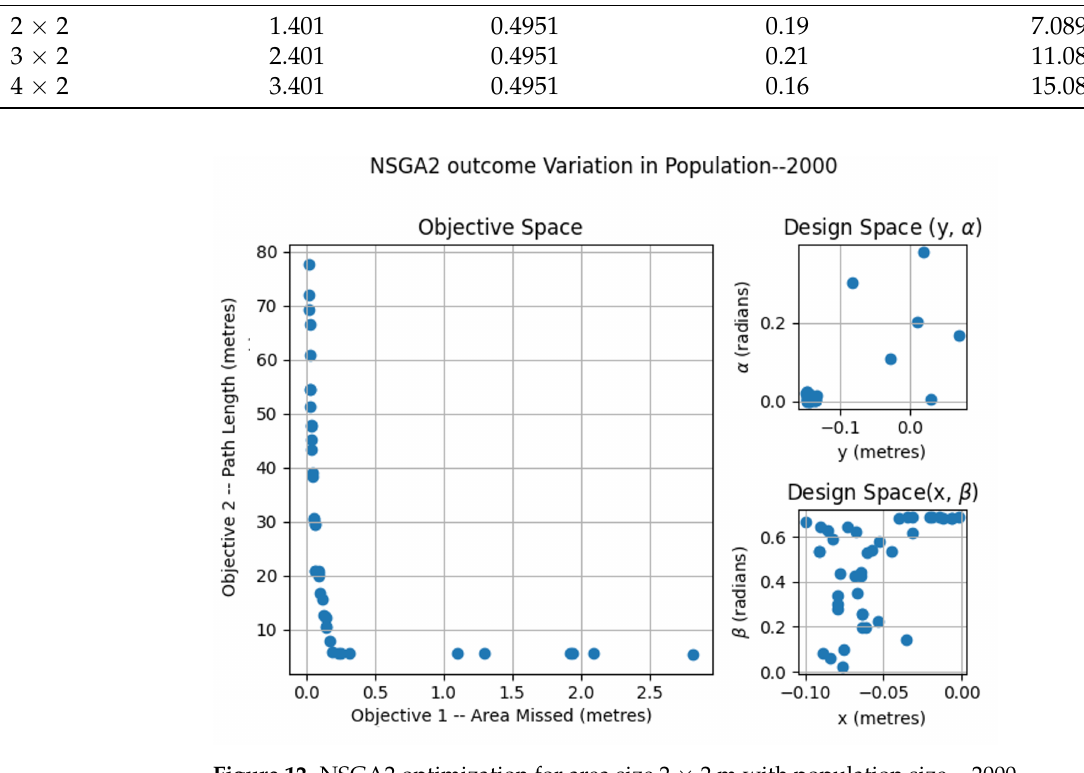
Figure 12. NSGA2 optimization for area size 2 × 2 m with population size = 2000.